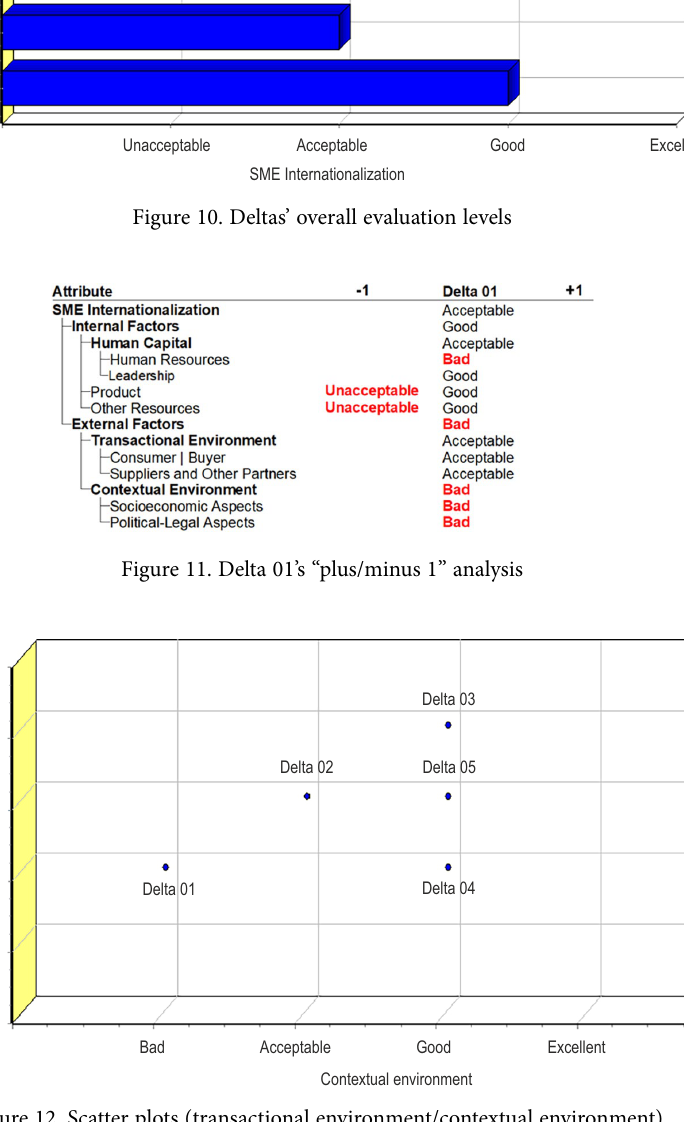
Figure 12. Scatter plots (transactional environment/contextual